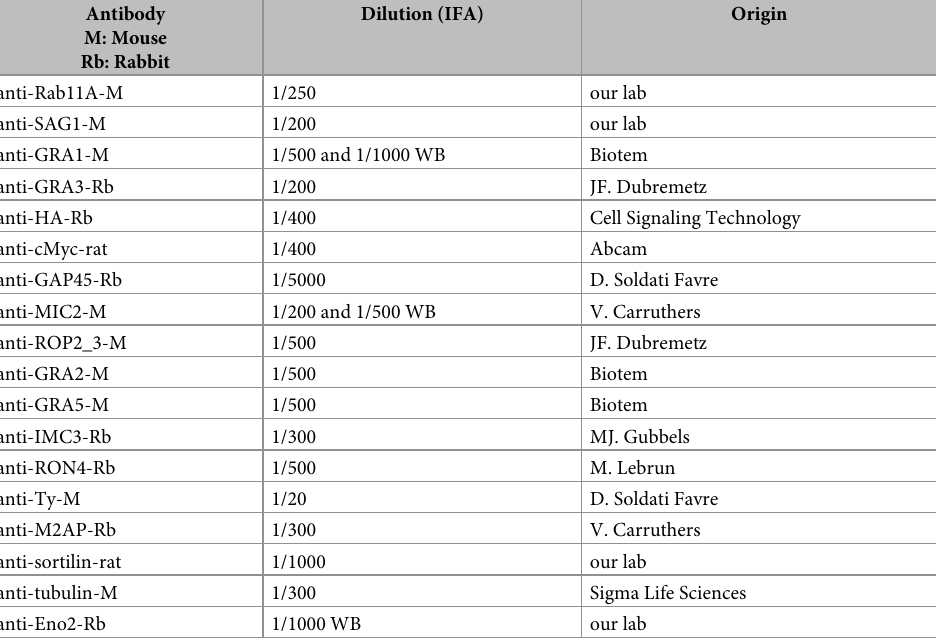
Table 2. List of